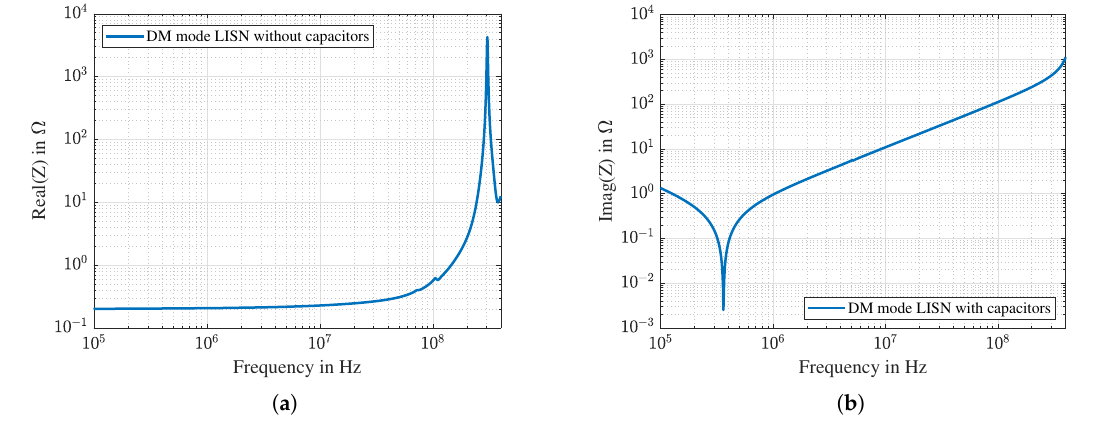
Figure 12. Validation of S-Parameter model by using an AC analysis. ( a ) Input impedance observed between LISN P and LISN M when Drain and Source of HS- and LS-switch are shorted (see Figure 11a). ( b ) Input impedance observed between LISN P and LISN M when the capacitors C 100 and C 101 are connected and the other ports are left open (see Figure